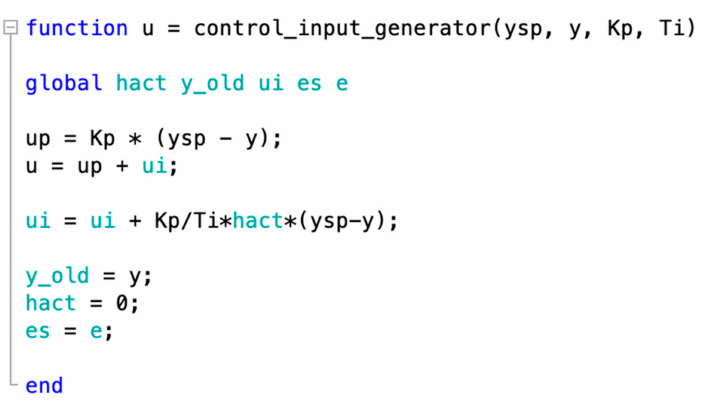
Figure 5. Control input generator